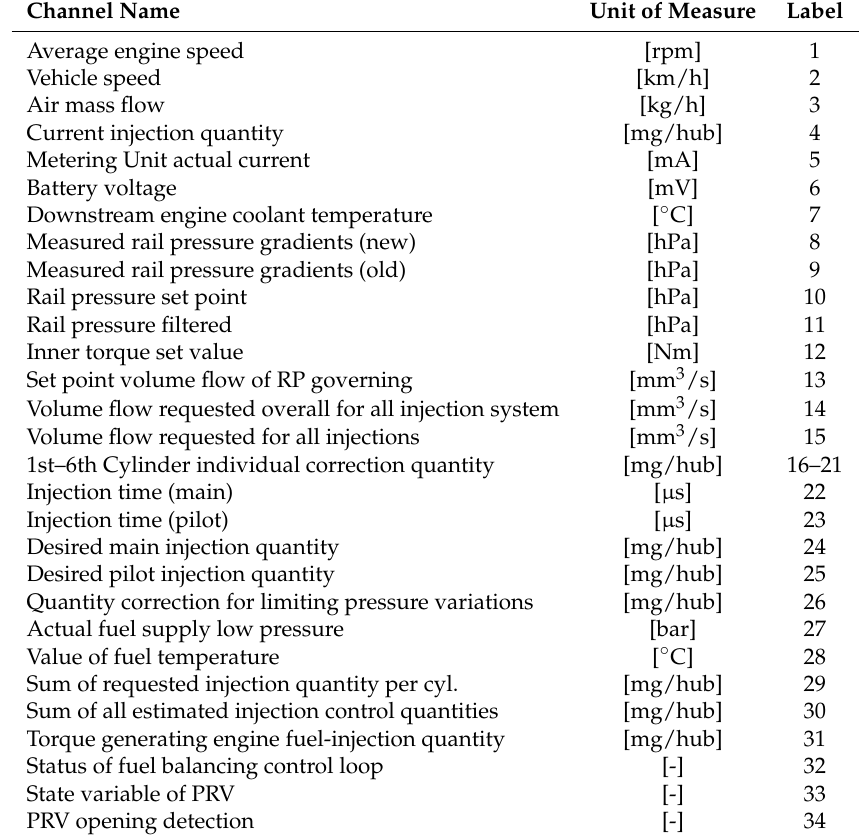
Table 1. List of channels. For each channel is reported the description, unit of measure and processing